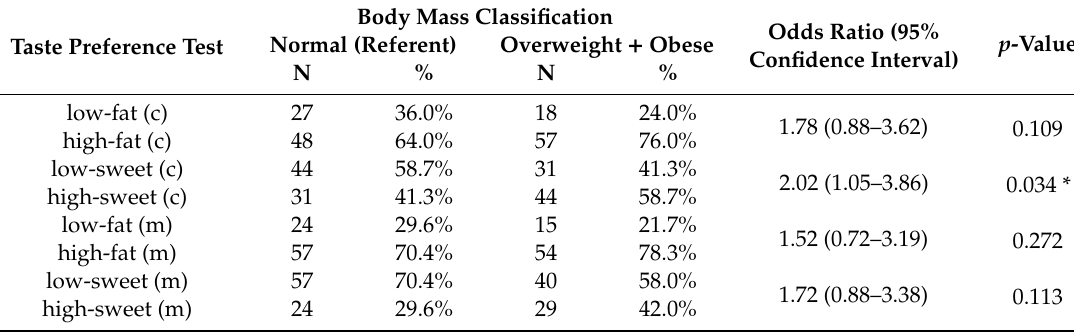
Table 3. Probability of being overweight / obese associated with high-fat and high-sweet taste preferences among children and their